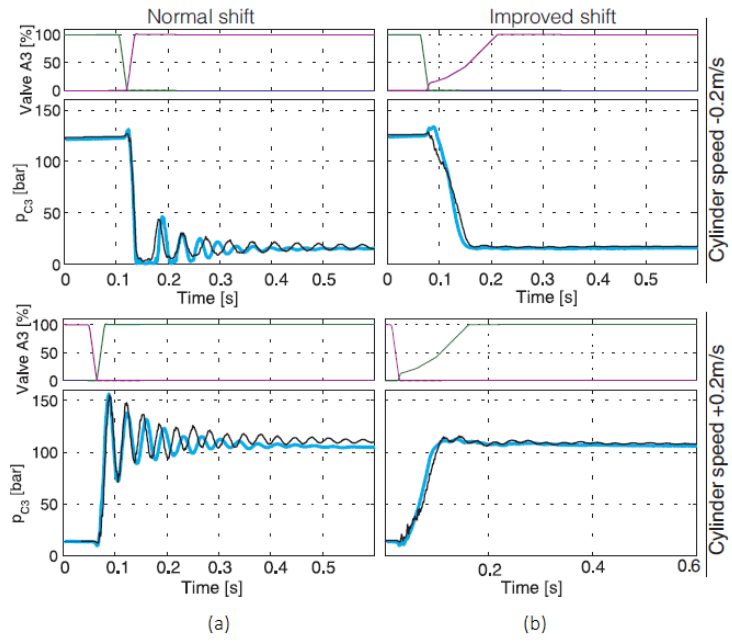
Figure 8. Comparison between the normal ( a ) and improved ( b ) valve opening control strategies [89]. Kindly provided by Rico H.